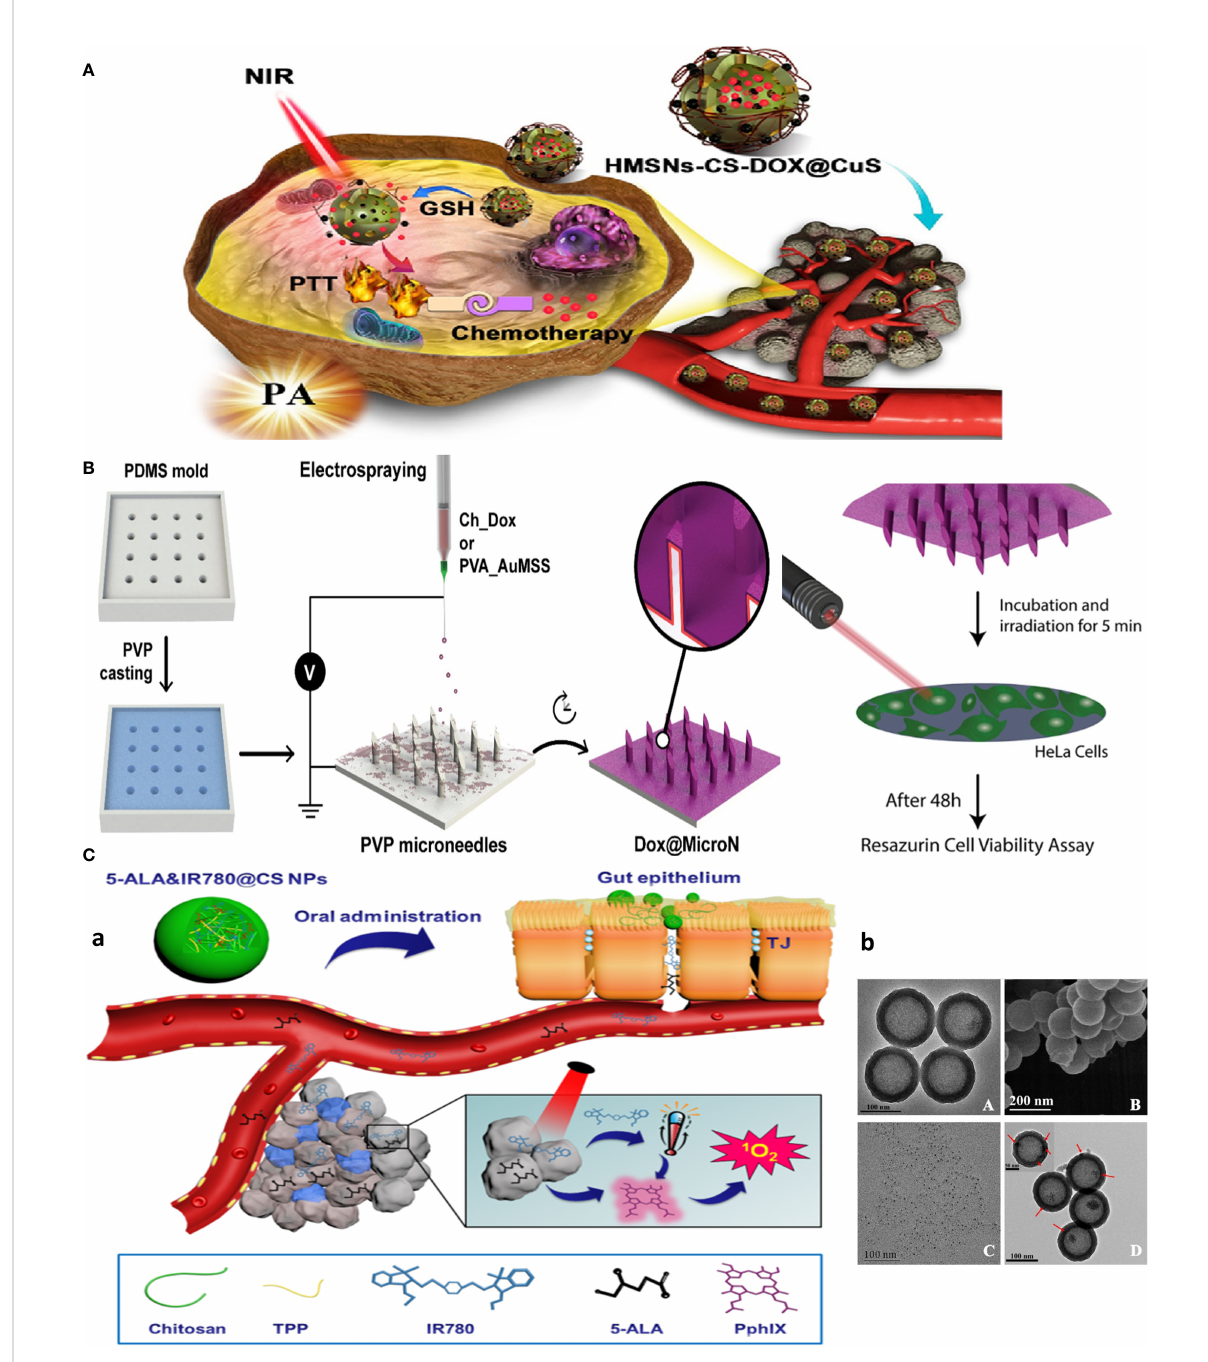
FIGURE 3 Chitosan-based multitasking drug delivery systems for treatment of MDR cancer. (A) Chitosan-based multimodal system for PTT-enhanced PDT therapy. Reprinted with permission from (36), Copyright (2020) Elsevier. (B) Chitosan MN patches for combined chemo-PTT cancer therapy. Reprinted with permission from (37), Copyright (2020) Elsevier. (C) Chitosan-based theranostics for thermal-photoacoustic (PA) imaging-guided tumor chemo-PTT therapy. (a) Schematic of NP working design. (b) Electron microscopy images: (A) TEM and (B) SEM images of HMSNs. TEM image of (C) CuS nanodots (D) and HMSNs-CS-DOX@CuS. Red arrows indicate the CuS nanodots on the HMSN surfaces. Reprinted with permission from (38), Copyright (2021)